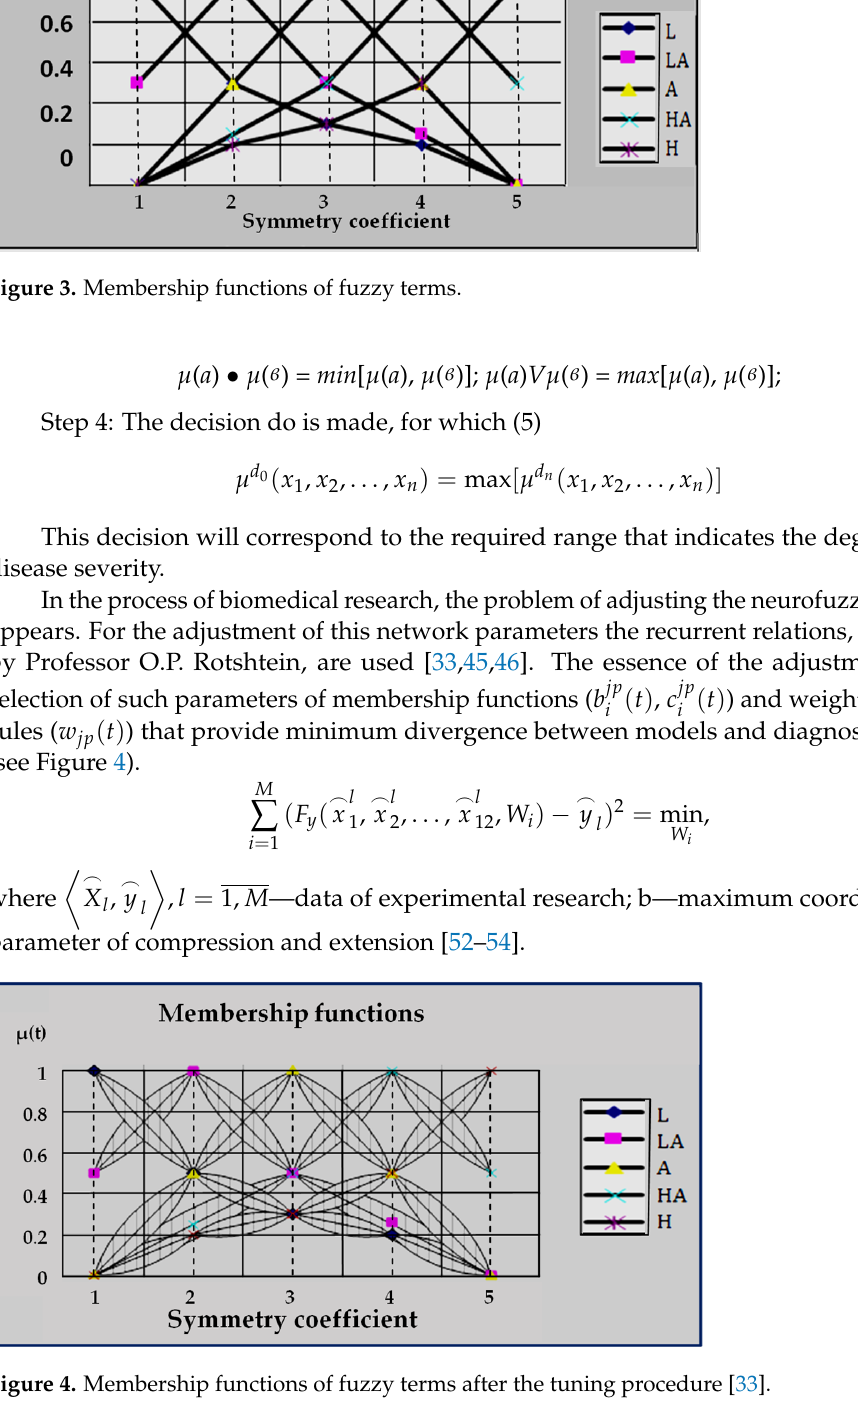
Figure 3. Membership functions of fuzzy terms.